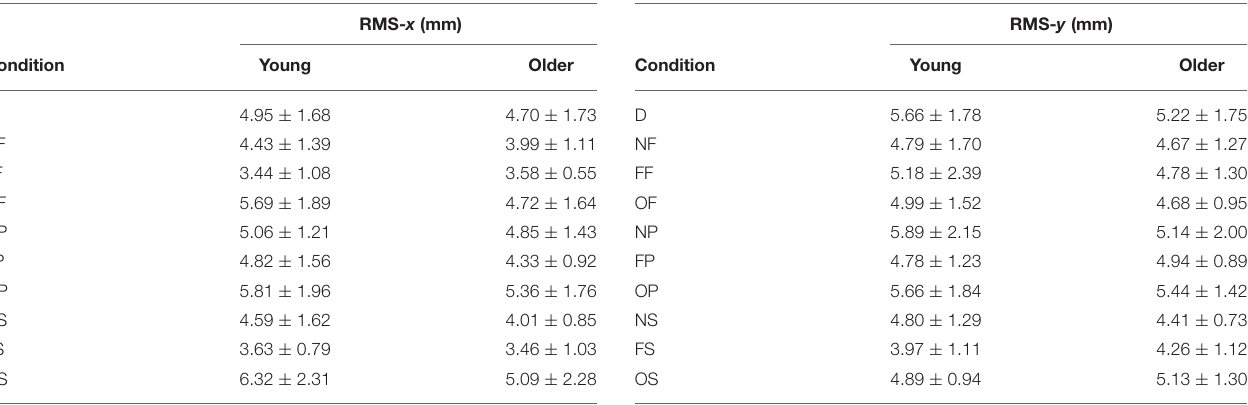
TABLE 3 | RMS of COP coordinate timeseries on the anterior/posterior ( y ) axis in young ( n = 12) and older ( n = 12) participants during different visual scene